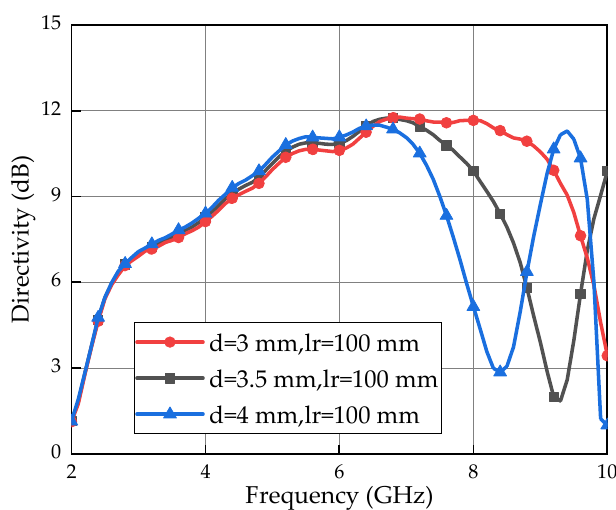
Figure 7. Directivity variation versus groove depth d. Electronics 2020 , 9 , x FOR PEER REVIEW